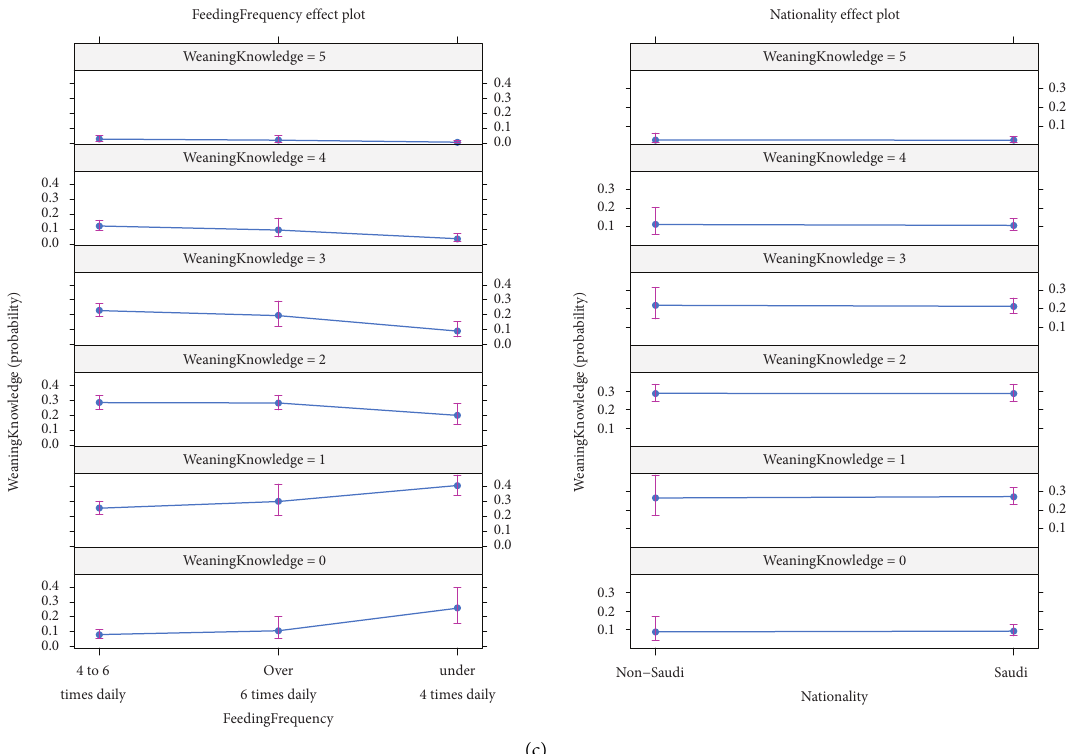
Figure 5: Estimates for the significant adjusted effects of clinical and demographic factors on knowledge